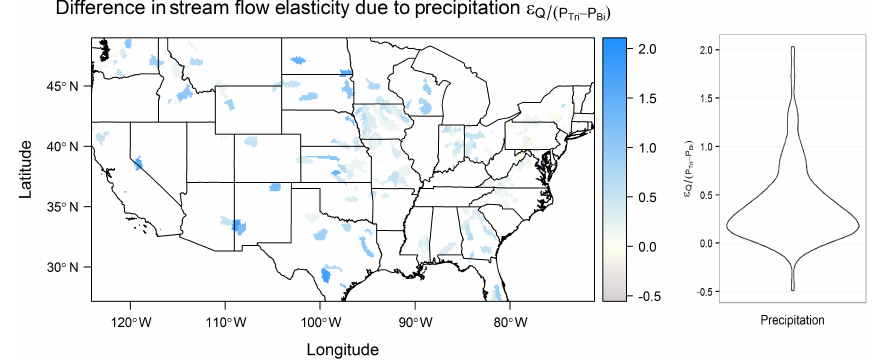
Figure 5. The difference between trivariate and bivariate precipitation elasticities (dimensionless). On the right side, a violin plot shows the distribution of these differences.